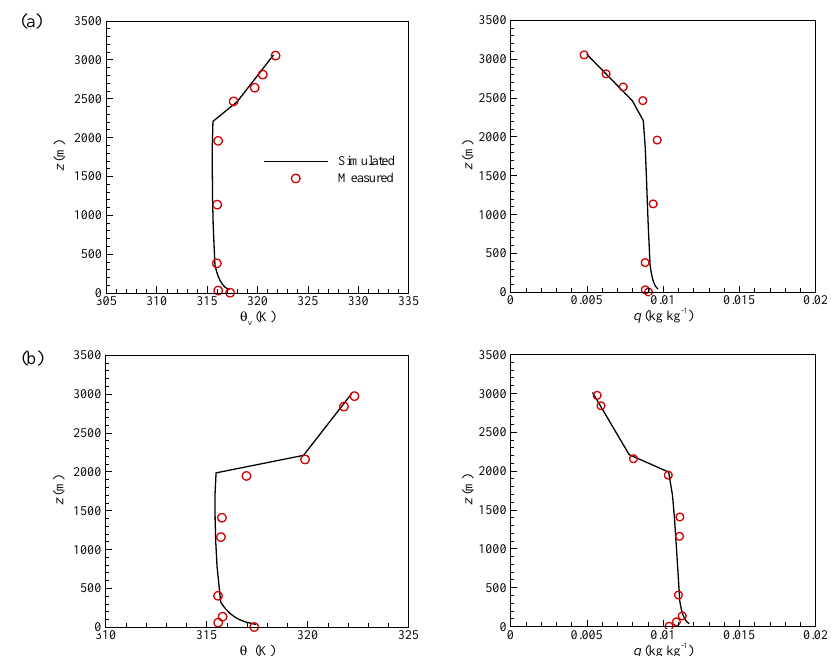
Figure 2. Comparison of simulated and measured atmospheric profiles of virtual potential temperature θ v and specific humidity q for two time points, i.e., (a) 16:44LT on 2 July 2013 and (b) 16:37LT on 9 July 2013 at NOAA-ESRL Phoenix site.